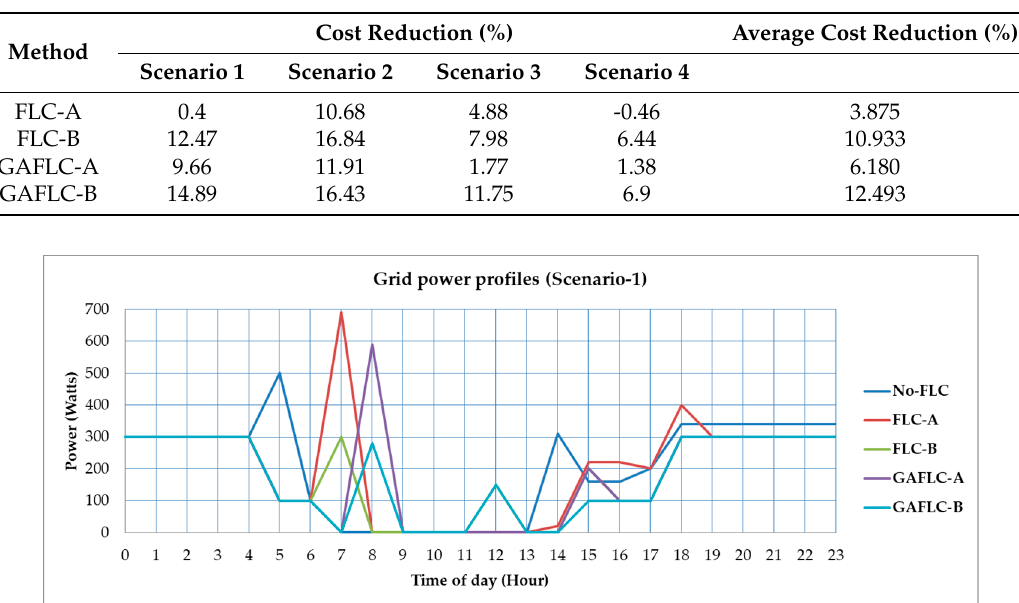
Table 8. Average cost reduction.